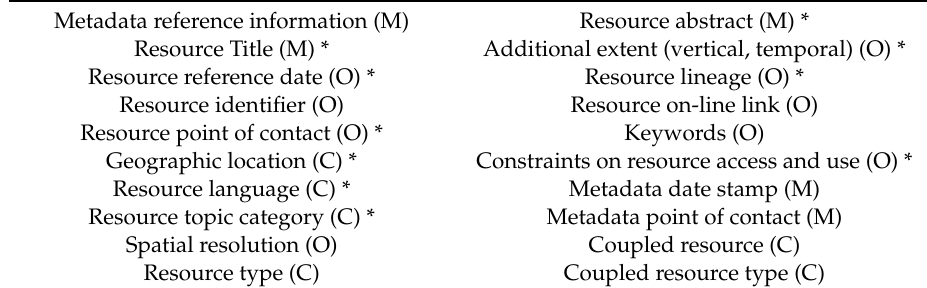
Table 2. Discovery metadata for geographic